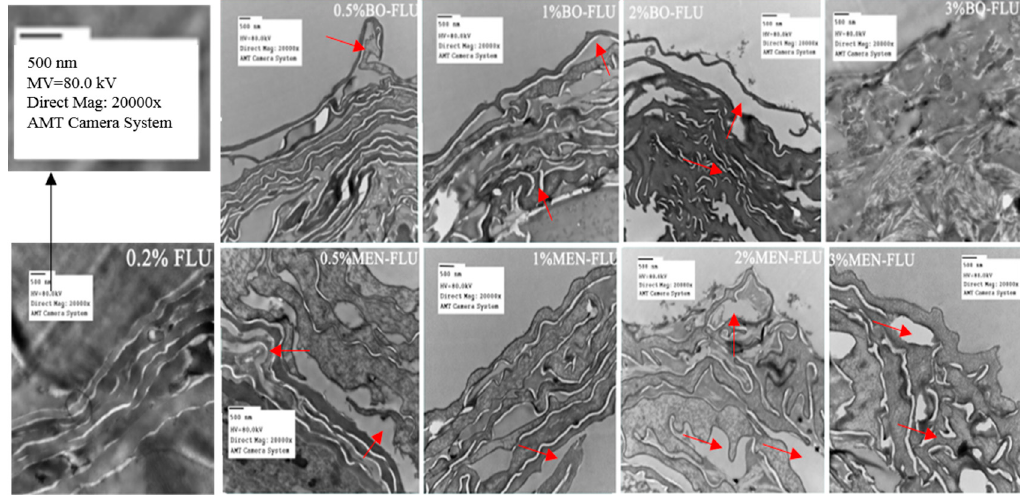
Figure 1. Transmission electron micrographs of the epidermis after 24 h of drug treatment (Magnification: 20,000 at 80 kV). From left to right, the concentration of PE was 0.0%, 0.5%, 1%, 2%, 3.0%. The picture labeled with “0.2% FLU” was the reference group not treated with penetration enhancer, 0.2% was the concentration of 5-FU, which was selected based on our pre-experiment, see Supplementary Materials. The picture labeled with “BO-FLU” was the group treated with borneol ( top ), and “MEN-FLU” for the group treated with menthol ( below ). The red arrows were used for the indication of disturbance on SC structure, and because of the obviously irreversible damage done by borneol at a penetration enhancers (PE) concentration of 3%, no arrows were used in the picture.